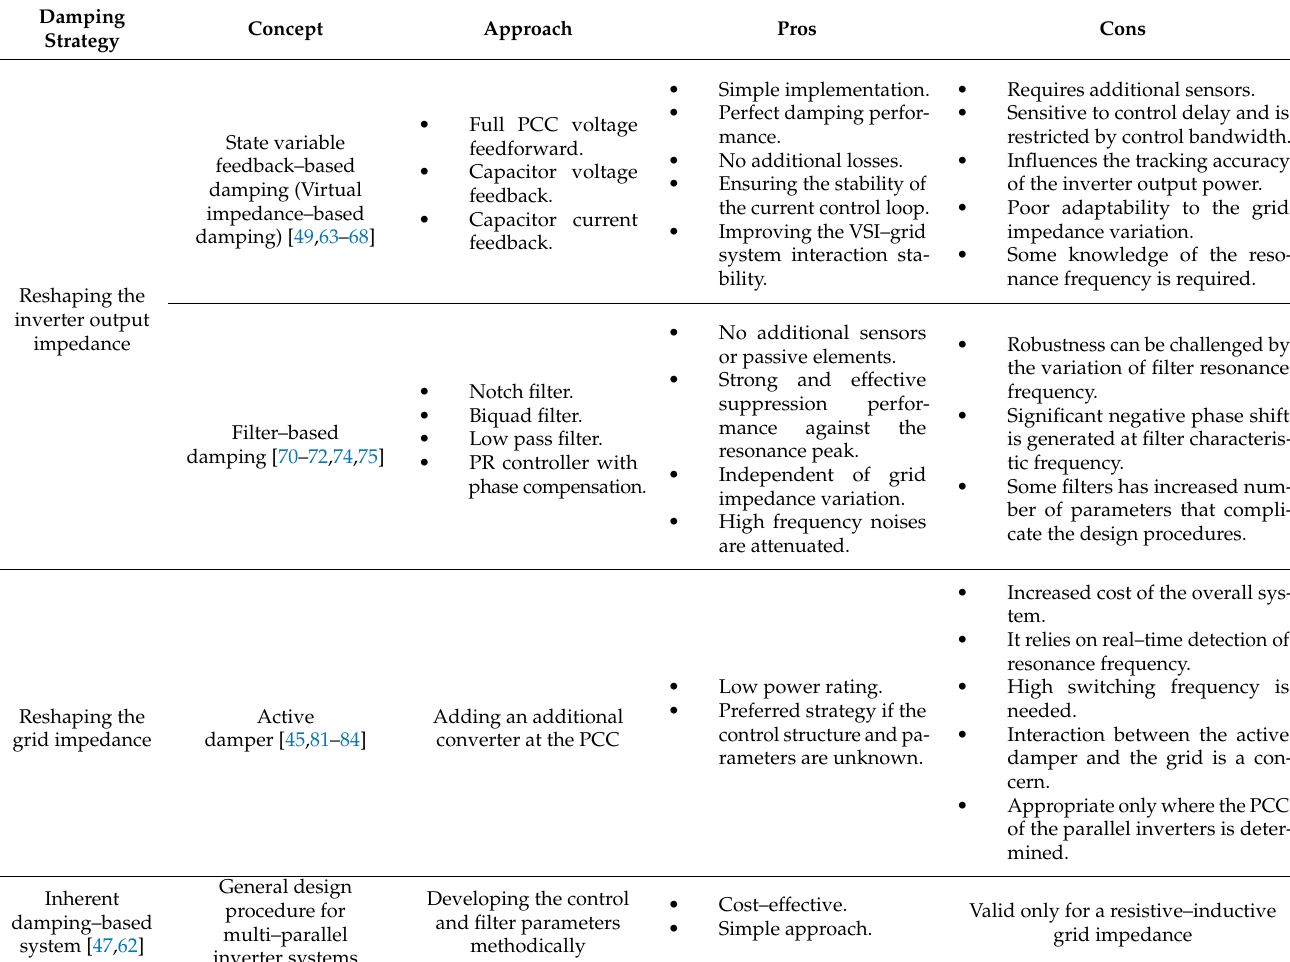
Table 2. Comparison of different damping